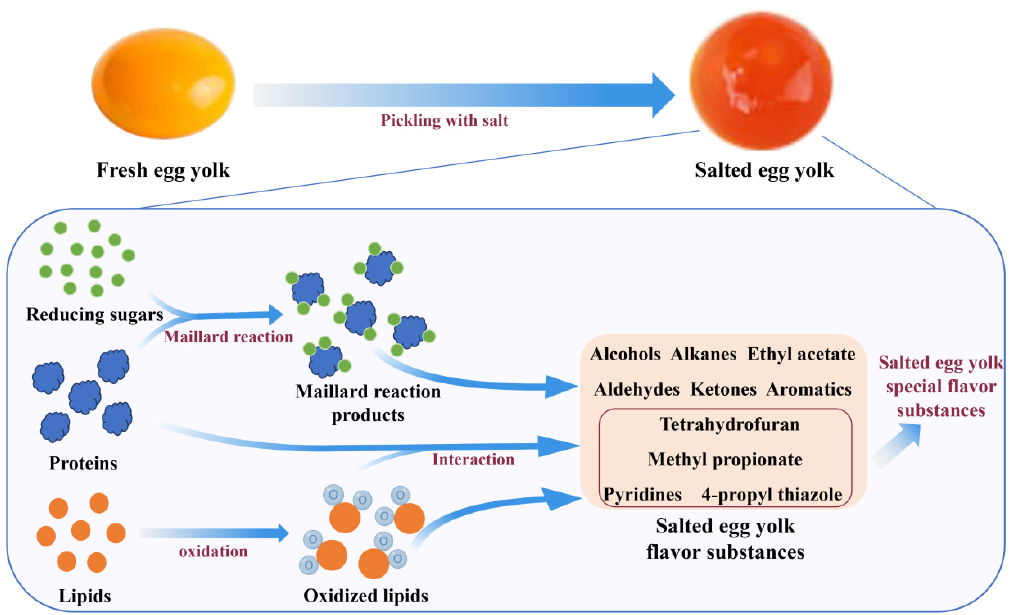
Figure 5. Flavor formation mechanism of salted egg yolk and the flavor substances of salted egg yolk.